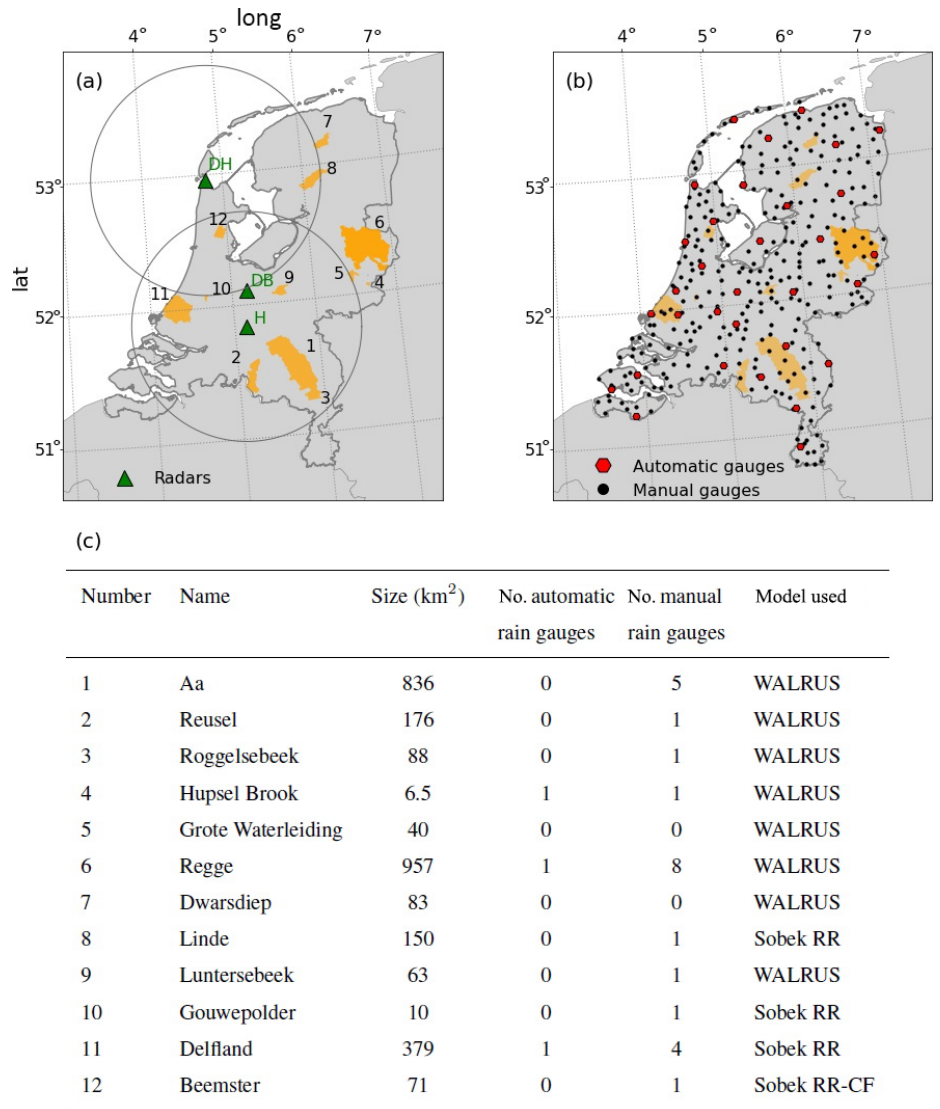
Figure 1. Overview of the basins in this study: (a) study area with the location of the three radars (green triangles) operated by KNMI and the 12 basins (orange polygons). The two grey circles indicate a range of 100km around the radars in Den Helder (DH) and Herwijnen (H). The other radar (DB) is the radar in De Bilt, which was used until January 2017 and replaced by the radar in Herwijnen. Note that the range used in the composite was more than 100km, but 100km is often regarded as the distance up to which the radar QPE is expected to be reliable. (b) Locations of the 32 automatic and 319 manual rain gauges currently operated by KNMI. Note that the number of rain gauges has slightly changed from 2009 until present. (c) List of the basin names, sizes, number of gauges in the basin and hydrological models employed. The numbers in the left column refer to the numbers in (a) . The right column states the used model for these areas.